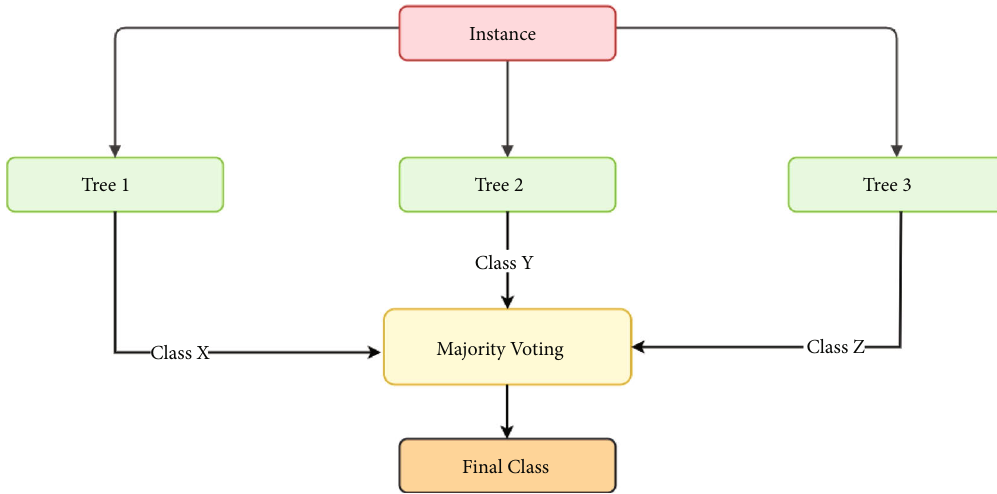
Figure 6: Random forest classi fi er model.